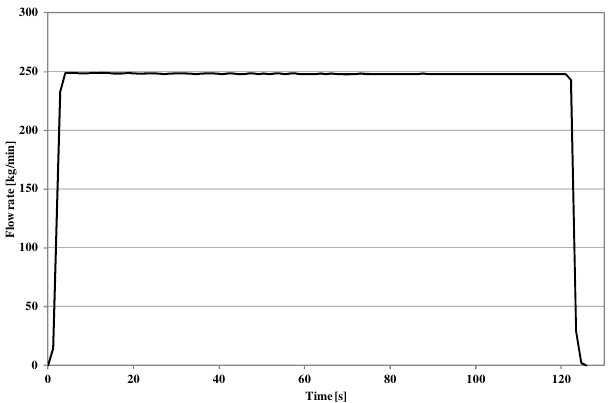
Fig. 4. Flow rate during one calibration run. Note: in Fig- ure 4 you can see that the flow rate is very stable during one calibration run. There are little to no flow rate changes